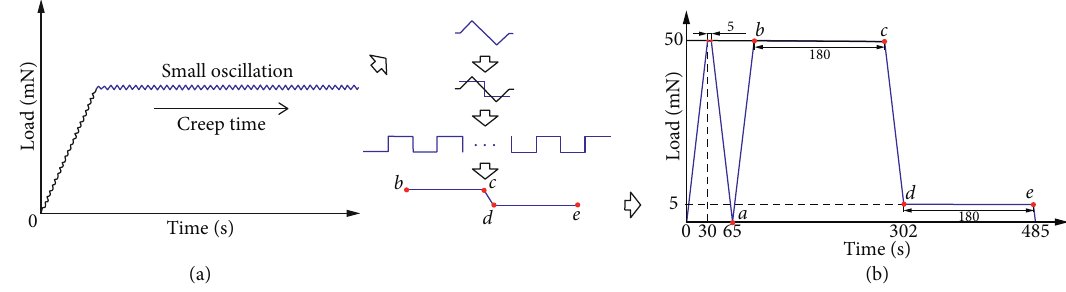
Figure 1: (a) The schematic illustration of the oscillation amplification method and (b) the experimental